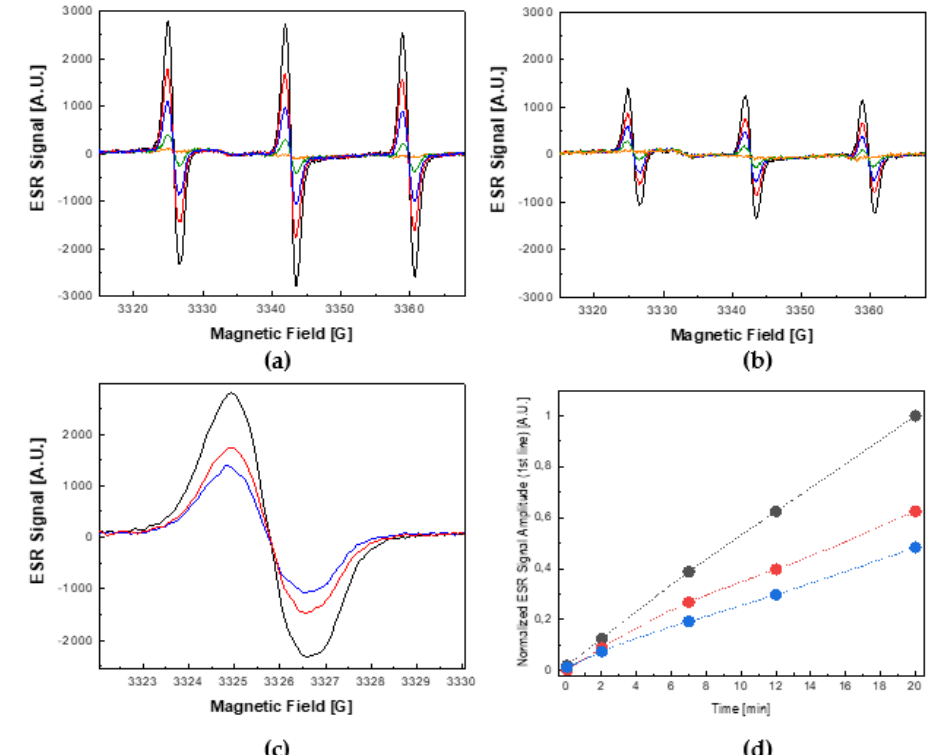
Figure 3. Photosensitized generation of a singlet oxygen ( 1 ∆ g ) by 100 µ M methylene blue under visible light illumination (150 W halogen) in the absence and presence of EGFP. ( a ) Growth of the ESR signal of TEMPOL as a function of illumination time in the absence of EGFP. ( b ) Growth of the ESR signal of TEMPOL as a function of illumination time in the presence of 20 μM EGFP. The ESR spectra presented in panels ( a , b ) were recorded in the dark (orange) and after 2 (green), 7 (blue), 12 (red), and 20 (black) min of visible light illumination. ( c ) Overlaid low-field features of the ESR signal of TEMPOL collected after 20 min of visible light illumination for the photosensitization processes performed: in the absence of EGFP (black trace), and in the presence of 10 µ M EGFP (red trace) and 20 µ M EGFP (blue trace). ( d ) Time-evolution of the signal amplitude of the low-field feature of the ESR spectra of TEMPOL observed in the absence of EGFP (black dots) and in the presence of 10 µ M EGFP (red dots) and 20 µ M EGFP (blue dots).